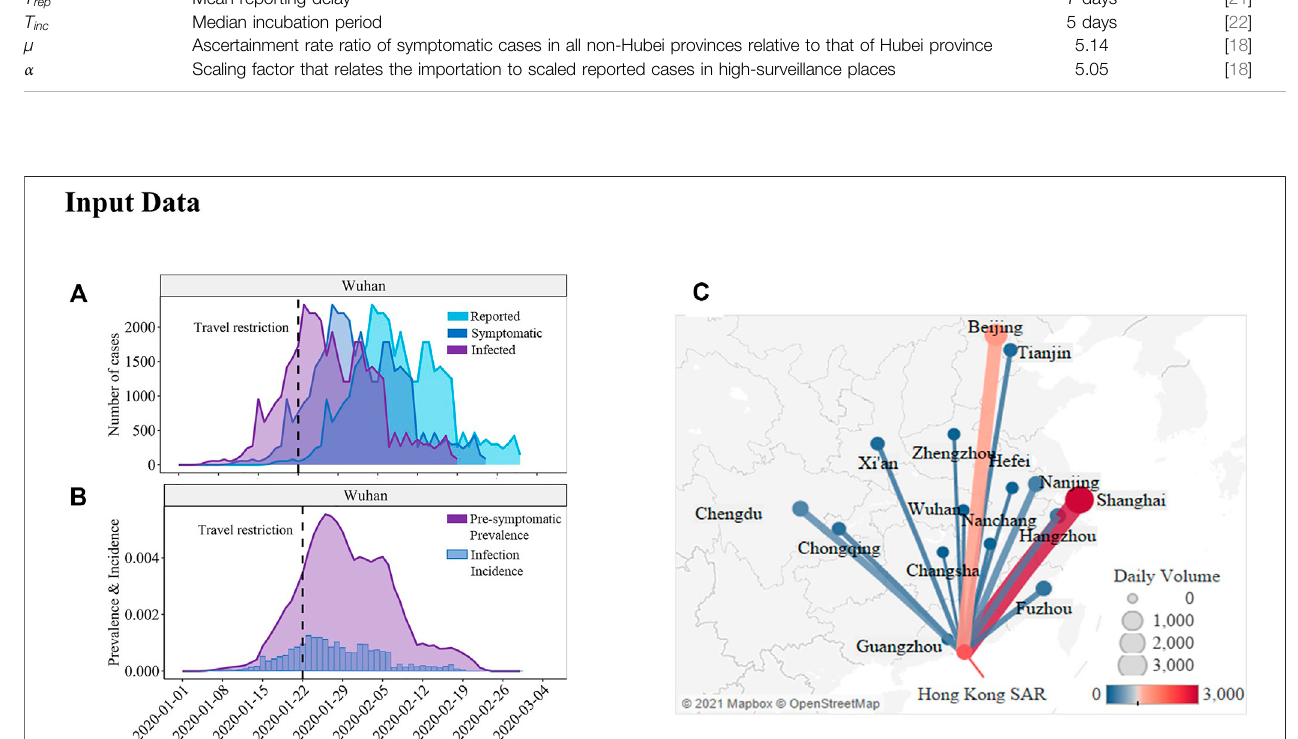
FIGURE 2 | The results of estimating the importation risk in the case study of Hong Kong. (A) Daily reported cases, estimated daily symptomatic cases based on daily reported cases, and estimated daily infected cases in Wuhan. (B) Daily pre-symptomatic prevalence and infection incidence during the study period in Wuhan. (C)